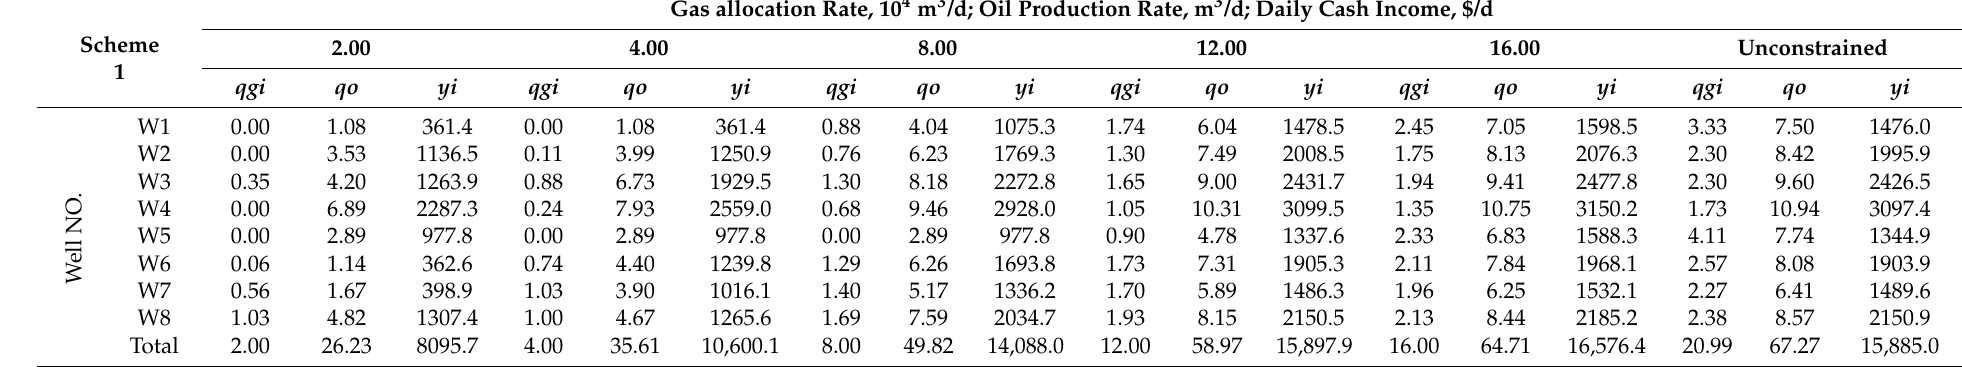
Table 4. Gas allocation result of various total injected gas rate of Scheme 1.